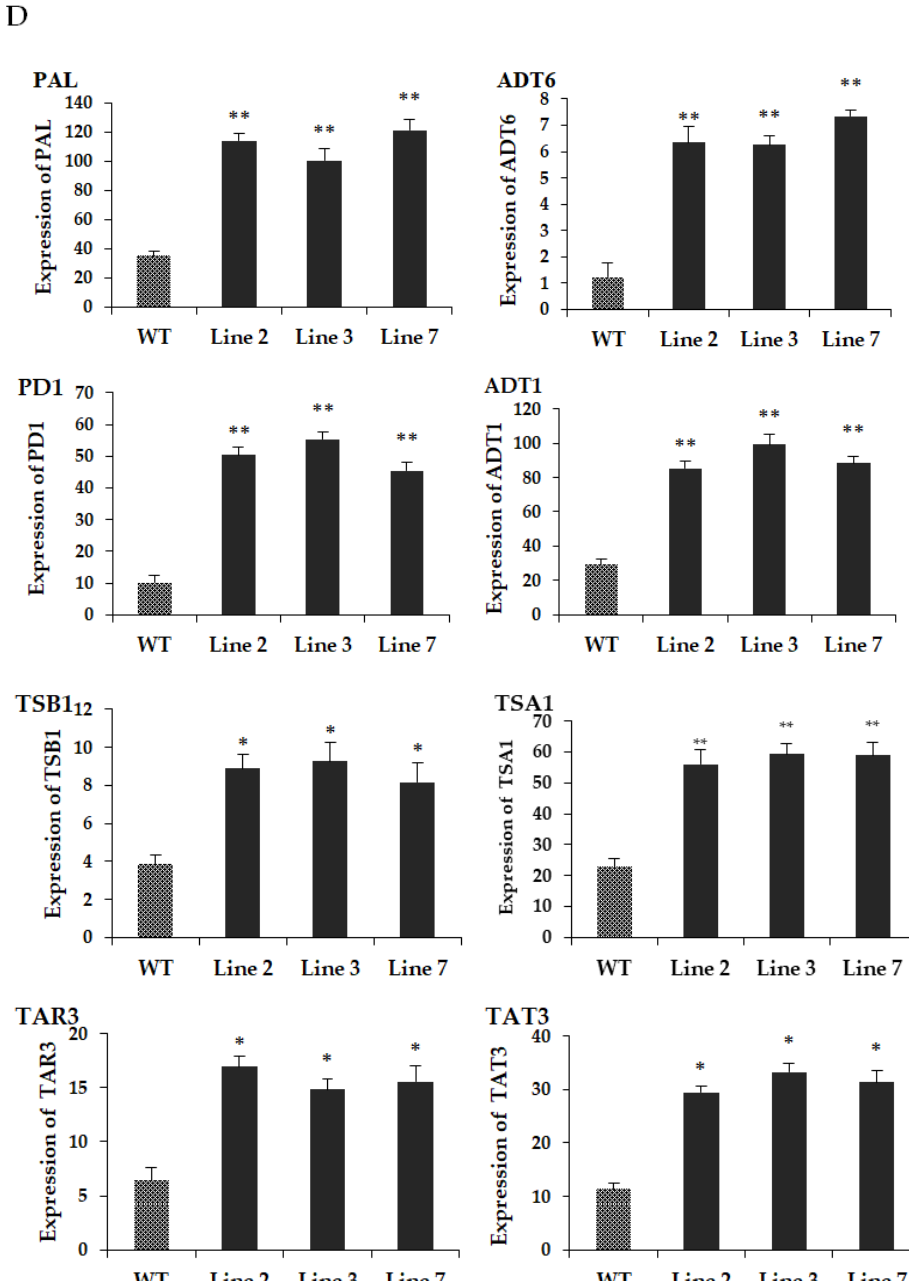
Figure 6. The verification of the MYB(t) gene in transgenic Arabidopsis . ( A ) Phylogenetic, motifs, and domain analysis of MYB(t) gene with homologous genes from other plant species, highlighting the MEME motif and two conserved SANT domains. ( B ) Comparison of hypocotyls of wild-type and three independent transgenic Arabidopsis lines. ( C ) Transgenic plants showed higher amino acid contents and higher antioxidant activity than wild-type plants. ( D ) Expression analysis of amino acid biosynthesis genes in transgenic Arabidopsis and wild-type by qRT-PCR. Abbreviations: PAL: phenylalanine ammonia-lyase, ADT6: arogenate dehydratase 6, PD1: prephenate dehydratase 1, ADT1: arogenate dehydratase 1, TSB1: tryptophan synthase beta-subunit 1, TSA1: tryptophan synthase alpha chain, TAR3: tryptophan aminotransferase 3, TAT3: tyrosine aminotransferase 3. The transgenic lines and wild-type plants were compared by students t -test at * p < 0.05; ** p < 0.01. Each graph bar illustrates the mean of three biological repeats.